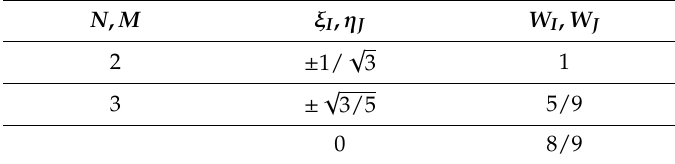
Table 1. Roots of Legendre polynomials and weighting coe ffi cients for the numerical integration. N , M ξ I , η